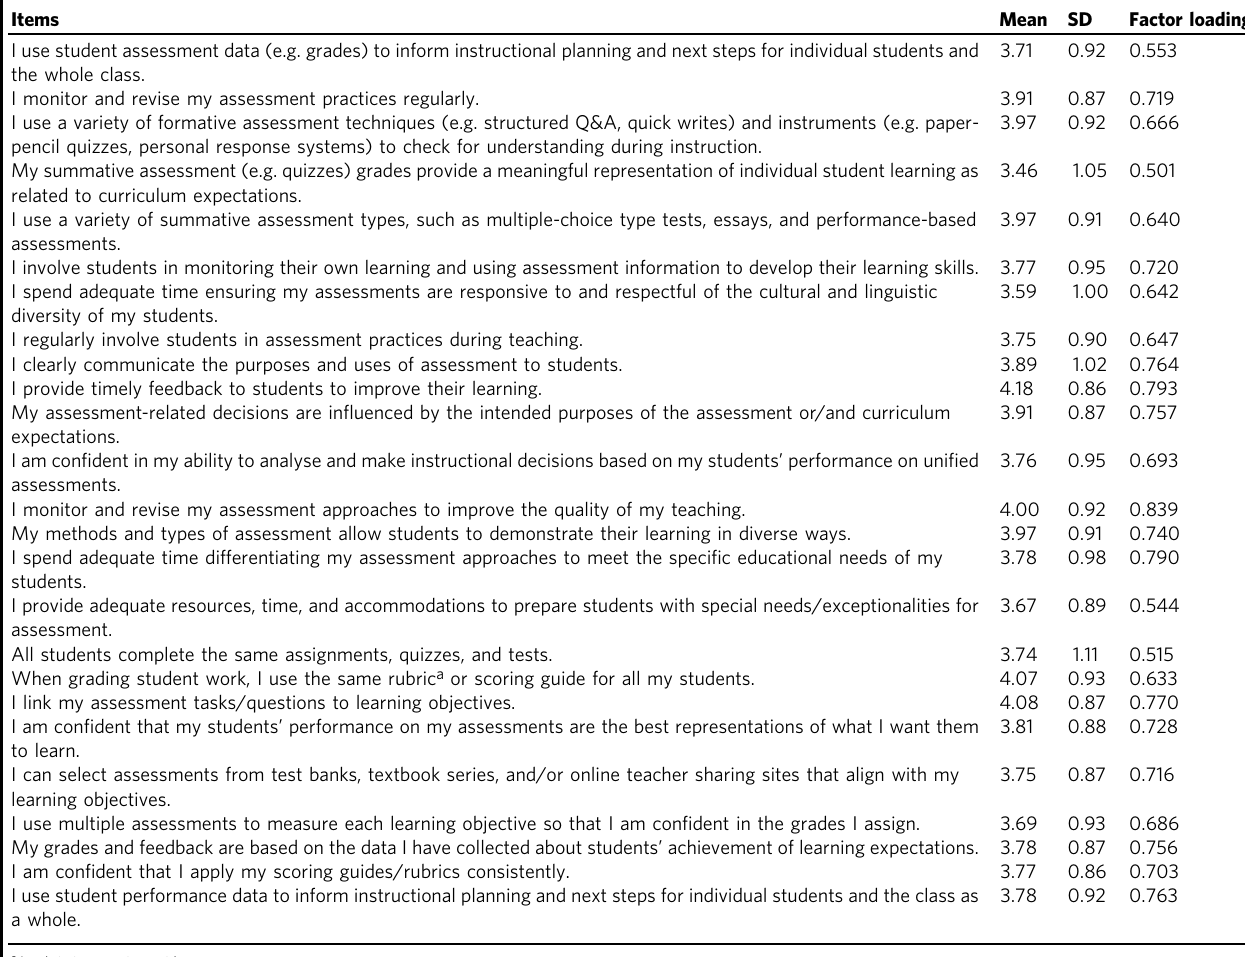
Table 3 Item-level descriptive statistics and exploratory factor